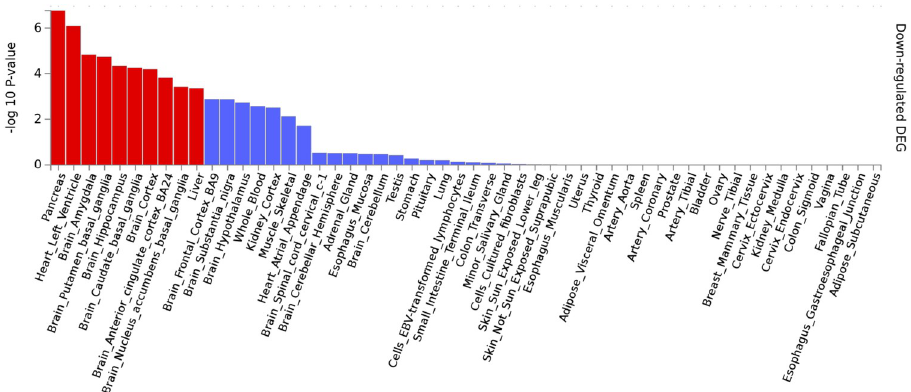
Fig 5. Differentially expressed down-regulated genes from FUMA. Red bars are indicative of statistically significant differentially expressed tissues based on Benjamini-Hochberg adjustment. Significance threshold p adj < 0.05.